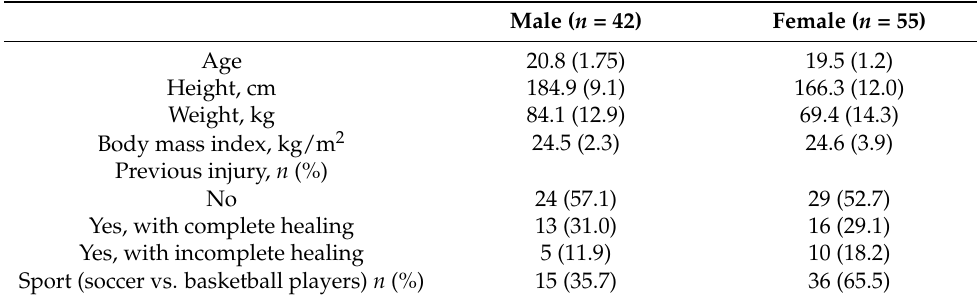
Table 1. Participant